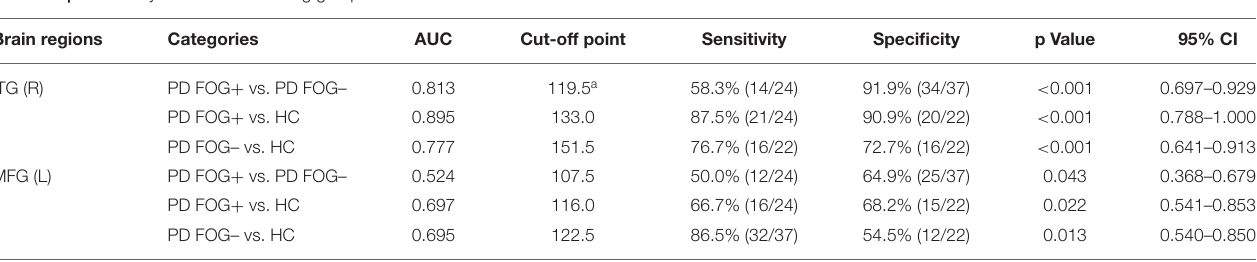
TABLE 3 | ROC analyses for differentiating